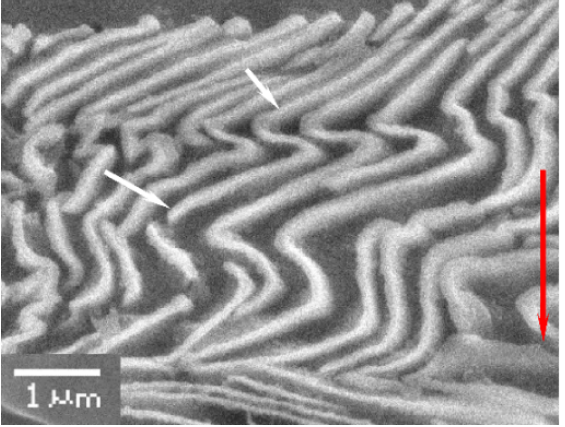
Figure 22. Deformation of cementite lamellae (ε z 2 = 0.75, Zone IV) (red arrow—direction of upset- ting).